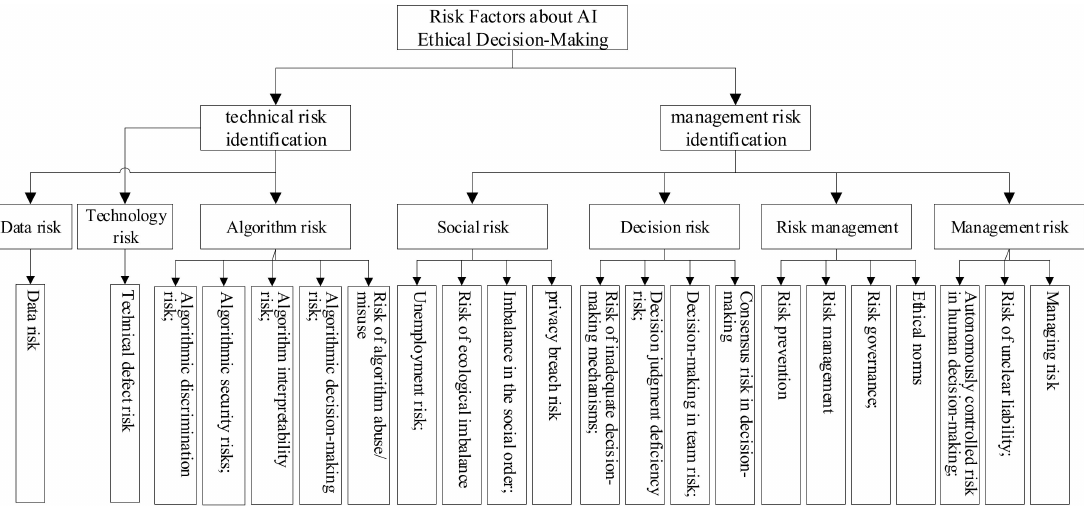
Figure 4. Structural model of the dimensions of ethical risk factors regarding AI decision